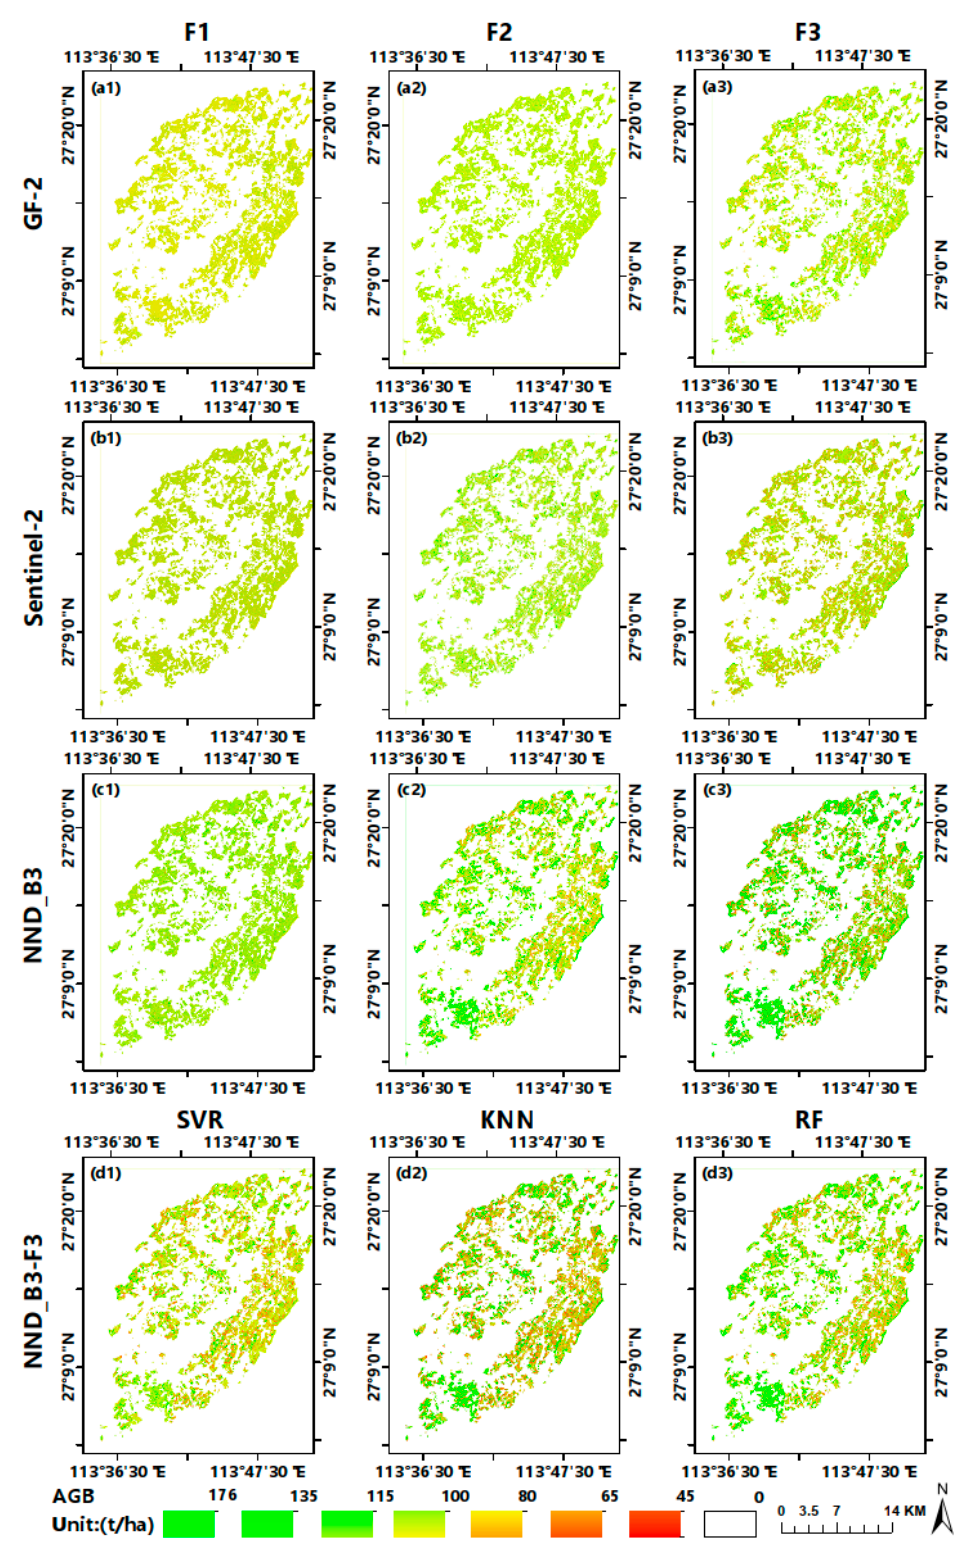
Figure 8. ( a1 – c3 ) the AGB distribution maps of Chinese fir plantations in the study area estimated by the 3 feature sets of GF2, Sentinel-2 and NND_B3 images based on stacking models; ( d1 – d3 ) the AGB distribution map estimated by the SVR, KNN, and RF models using the F3 feature variable set of the NND_B3 image.